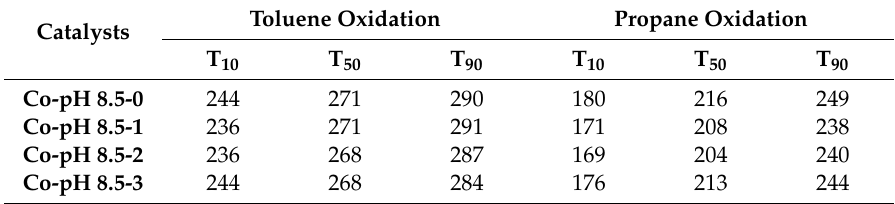
Figure 10. ( A ) Toluene and ( B ) propane oxidation over cobalt oxides prepared at pH 8.5 with different number of washings. Table 4. Temperature values of 10% (T 10 ), 50% (T 50 ) and 90% (T 90 ) toluene and propane conversion of cobalt oxides prepared at pH 8.5 with different number of washing.